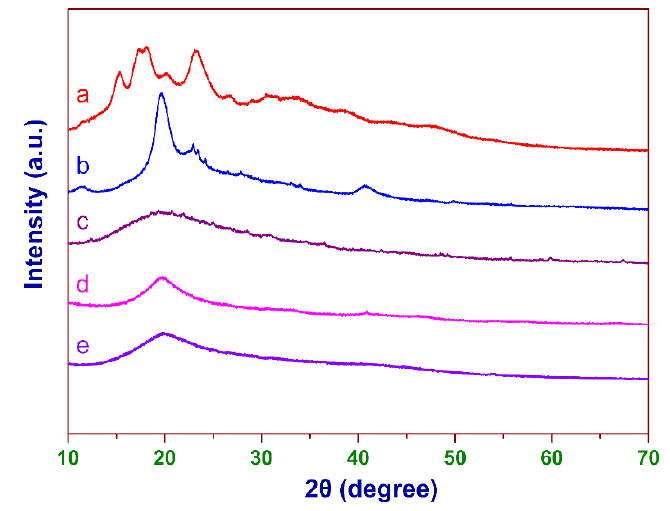
Figure 4. The XRD patterns of ( a ) starch, ( b ) PVA, ( c ) CCS, ( d ) CCP, and ( e ) CCSP2.